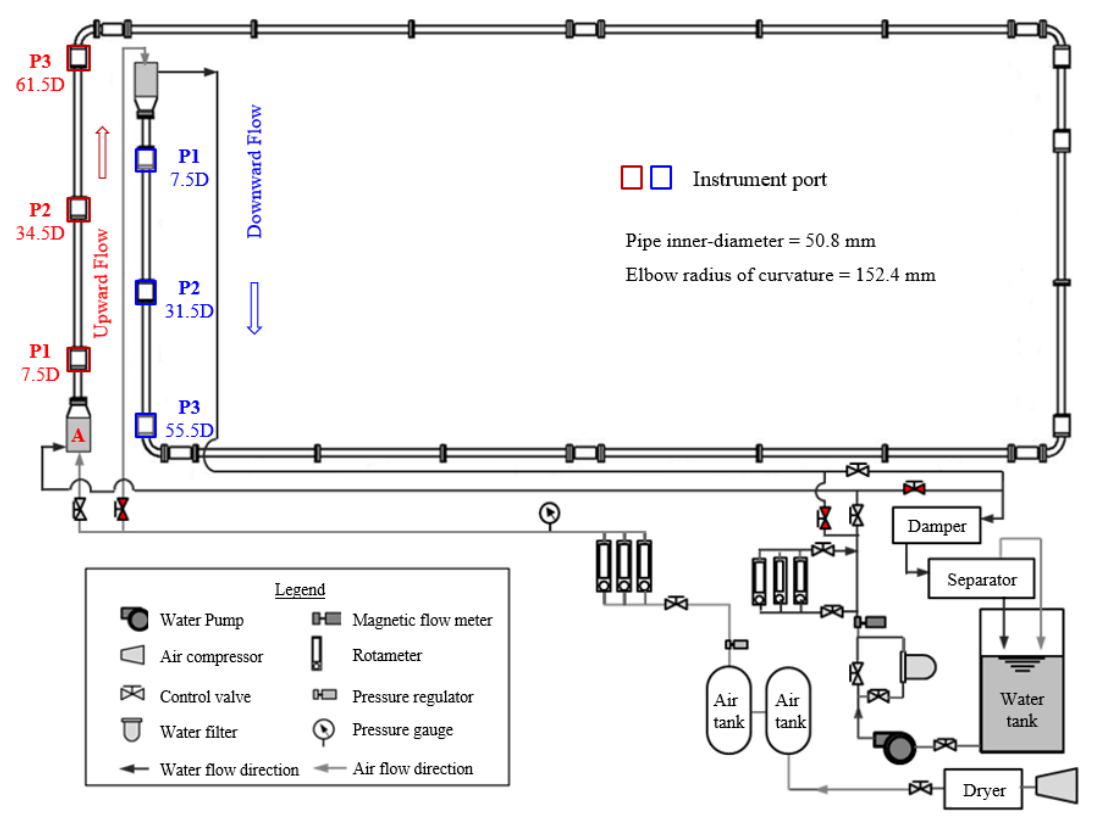
Figure 1. Schematic diagram of the test facility.